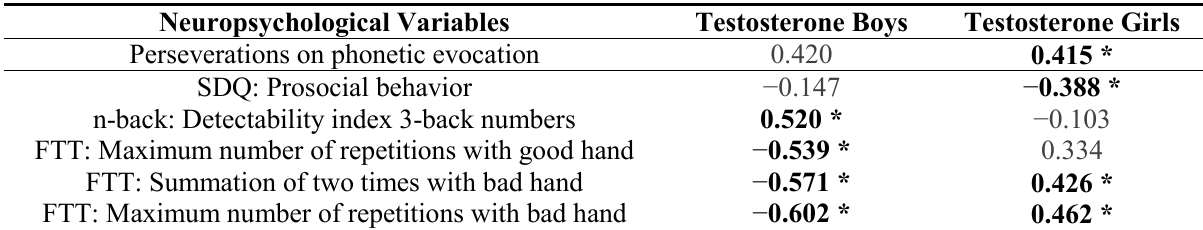
Table 4. Spearman correlations between testosterone levels in the blood of children (boys and girls separately) and neuropsychological variables ( N =